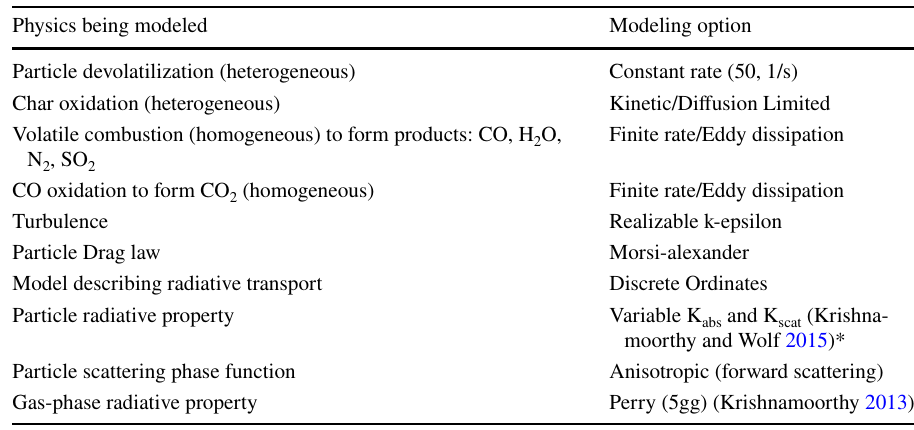
*These models were implemented as User-Defined Functions (UDFs) in ANSYS